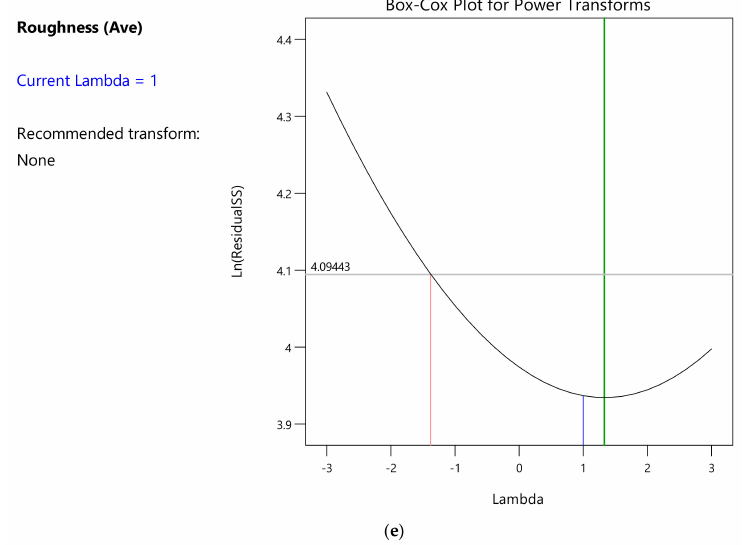
Figure A2. Statistical quality assertion: ( a ) Half-Normal plot vs. Externally studentized residuals for random error check, ( b ) Residuals vs. predicted value for independent residuals, ( c ) Residual vs. run for the absence of variation from printing location, ( d ) Cook’s distance plot for identification of outliers and ( e ) Box-Cox plot to identify any need of a transformation of the